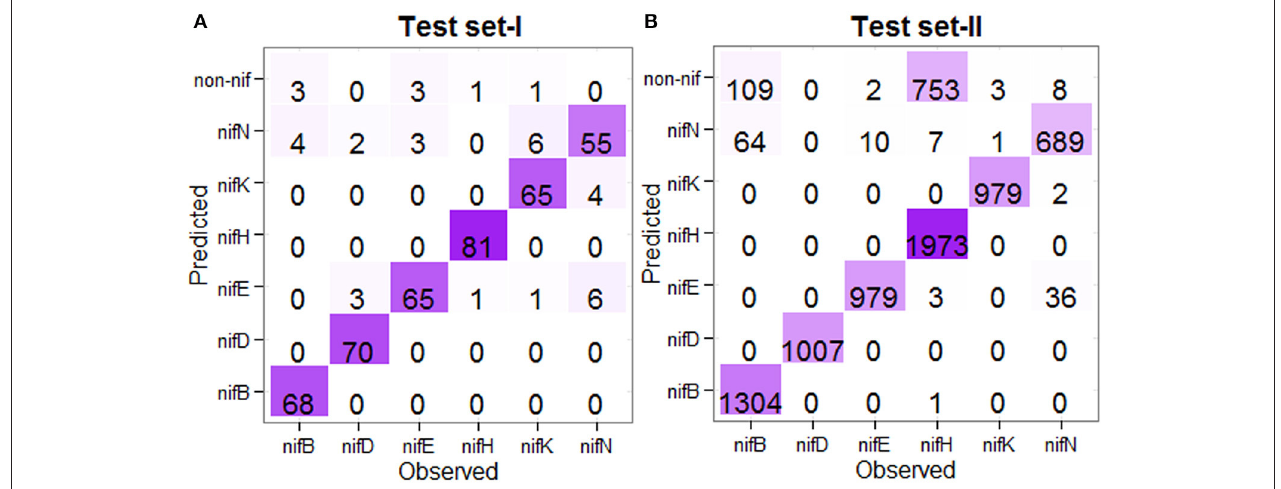
FIGURE 5 | Confusion matrices of the prediction results for the independent datasets. (A) Confusion matrix showing the prediction result for the Test set-I, and (B) Confusion matrix showing the prediction result for the Test set-II, where the prediction was made in two stages. The color from light to dark represents lower to higher numbers. For the Test set-I, except nifN category, > 90% sequences are correctly predicted in other five categories. Similarly for the Test set-II, except nifB and nifH , > 90% accuracies are observed in other